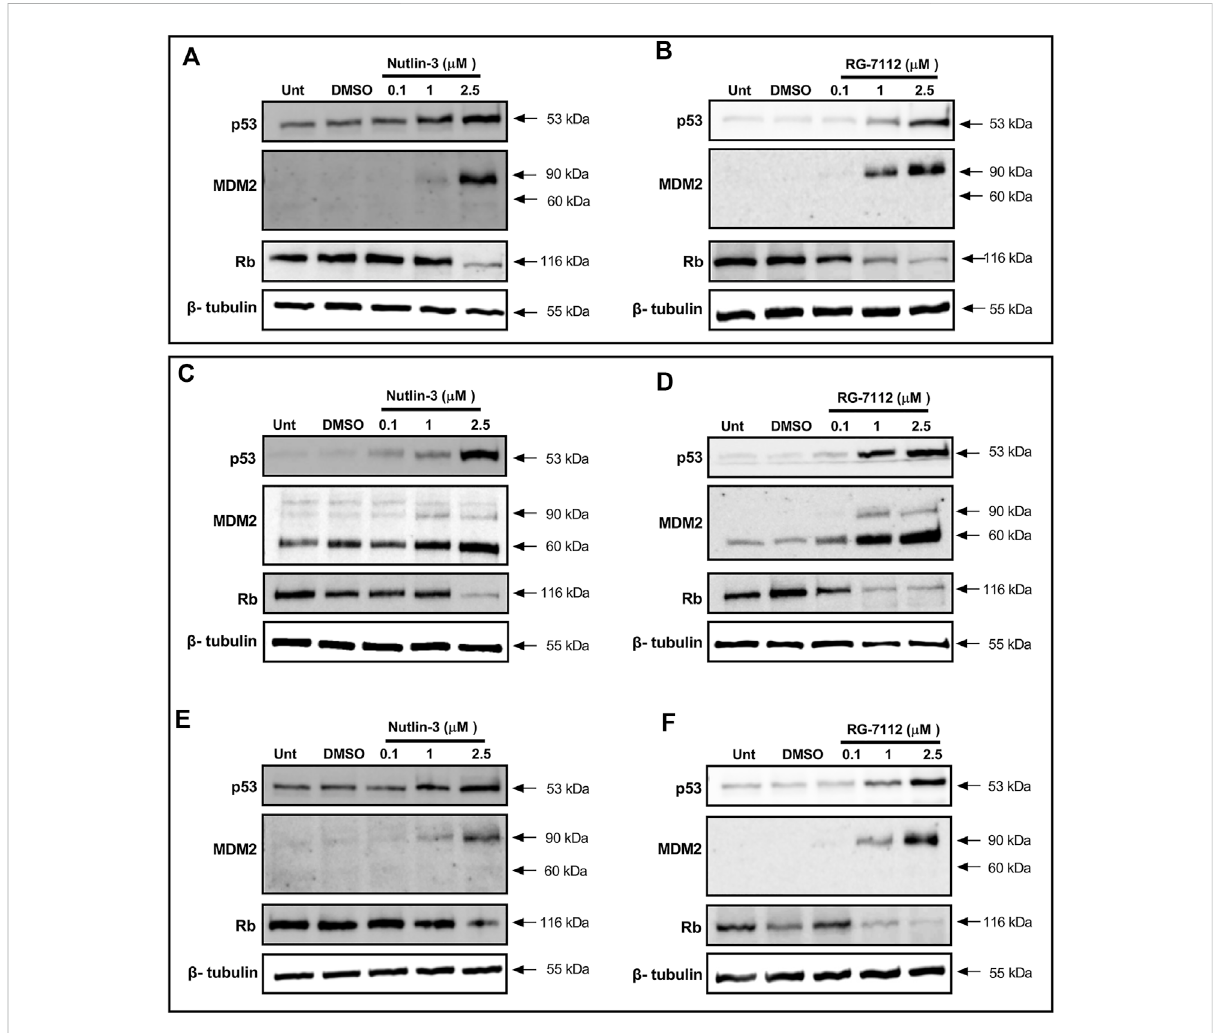
FIGURE 3 MDM2 inhibitors activate p53 pathway in alveolar basal epithelial cells. Western blotting analysis of p53, MDM2 and Rb proteins in A549-hACE2 cell cultures treated with different concentrations of Nutlin-3 (A,C,E) or RG-7112 (B,D,F) and relative controls (Unt, untreated; DMSO, control vehicle).Proteinlevelswereevaluated24 haftertreatments (A,B) and48 hafterSARS-CoV-2infection(correspondingto72 hafterinitialtreatment) in infected (C,D) and mock cultures (E,F) . Images are representative of three independent experiments. β -tubulin is used as internal